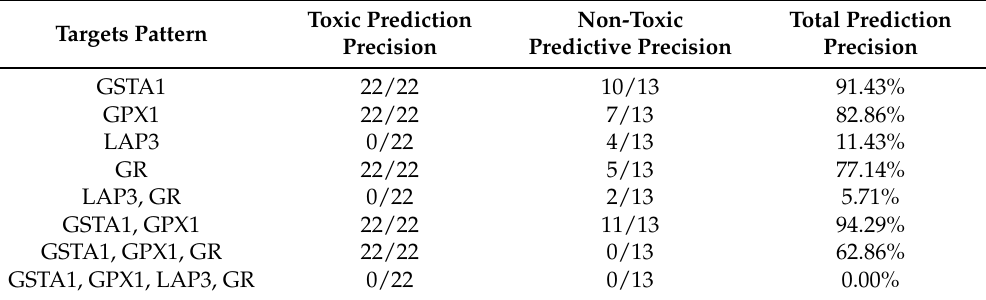
Table 2. Prediction precision of different targets